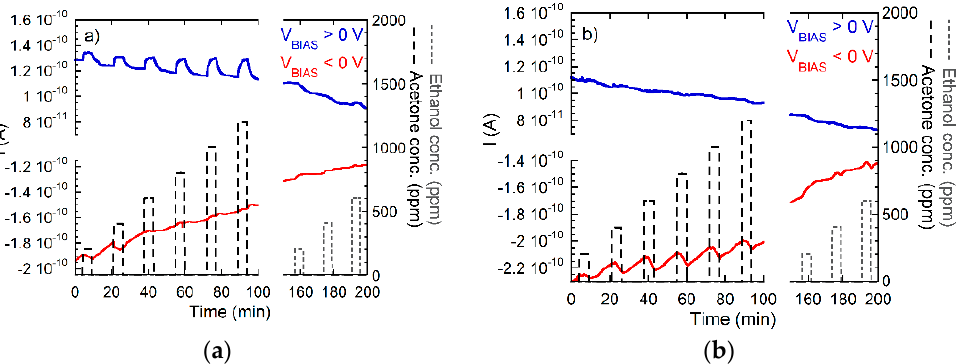
Figure 7. Response of CuO ( a ) and Pt emitters ( b ) to different concentrations of acetone and ethanol in dry air. Bias voltages were ± 30 𝑉 applied to the central electrode (with reference to Figure 6) and substrates being heated to 350 °C.